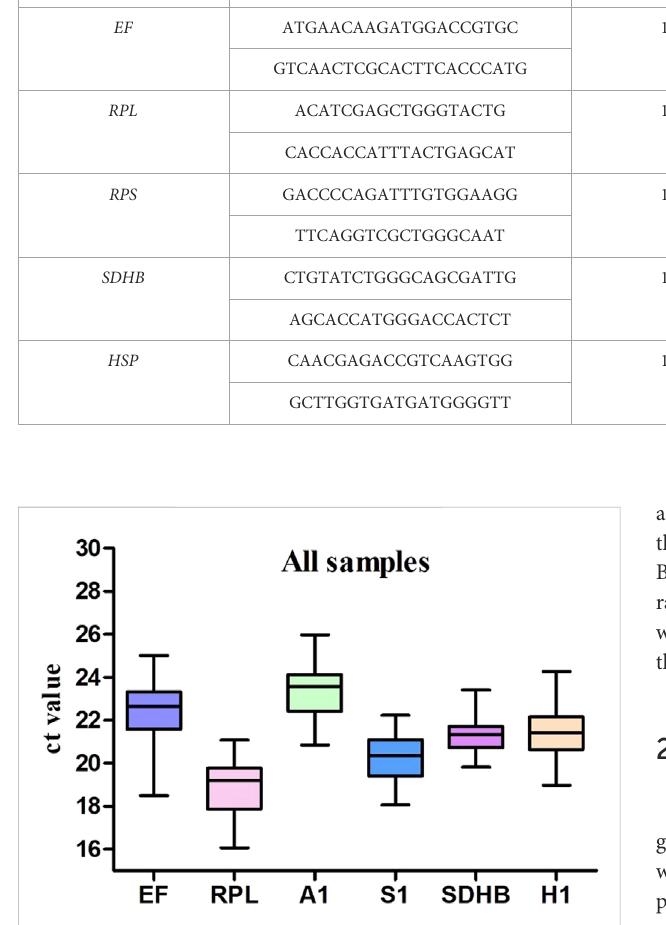
FIGURE 1 Expression pro fi les of reference genes in different treatment samples of Megalurothrips